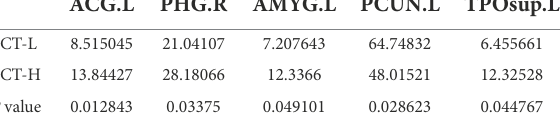
TABLE 5 Betweenness